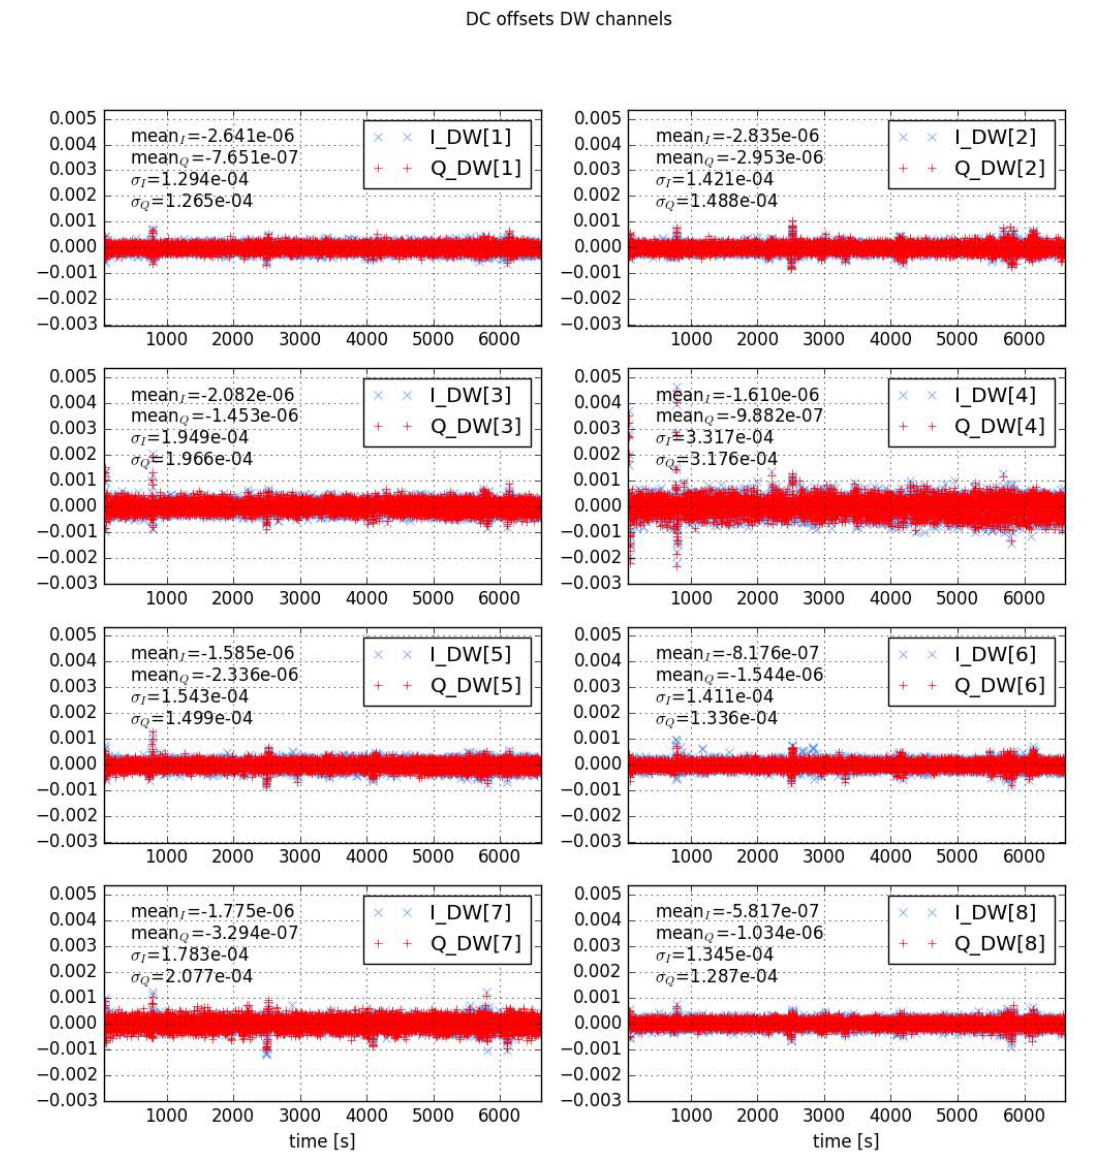
Figure 11. Measured DC offset of the recorded signals with working real-time DC compensation circuit in a steady state